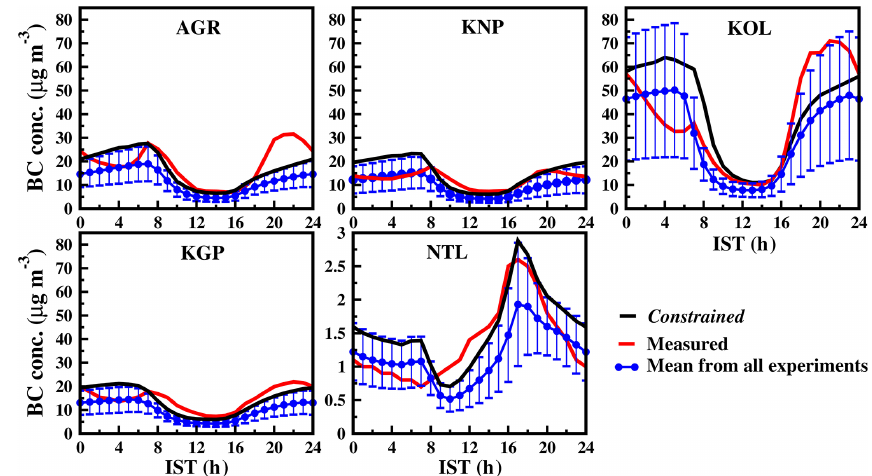
Figure 4. Hourly distribution of winter monthly mean BC concentration (µgm − 3 ) at stations from the Constrained simulation (black line). Note that the y axis is on a different scale for Nainital. The mean and the standard deviations (1 σ ) from the five simulations corresponding to the hourly winter monthly mean BC concentration are also